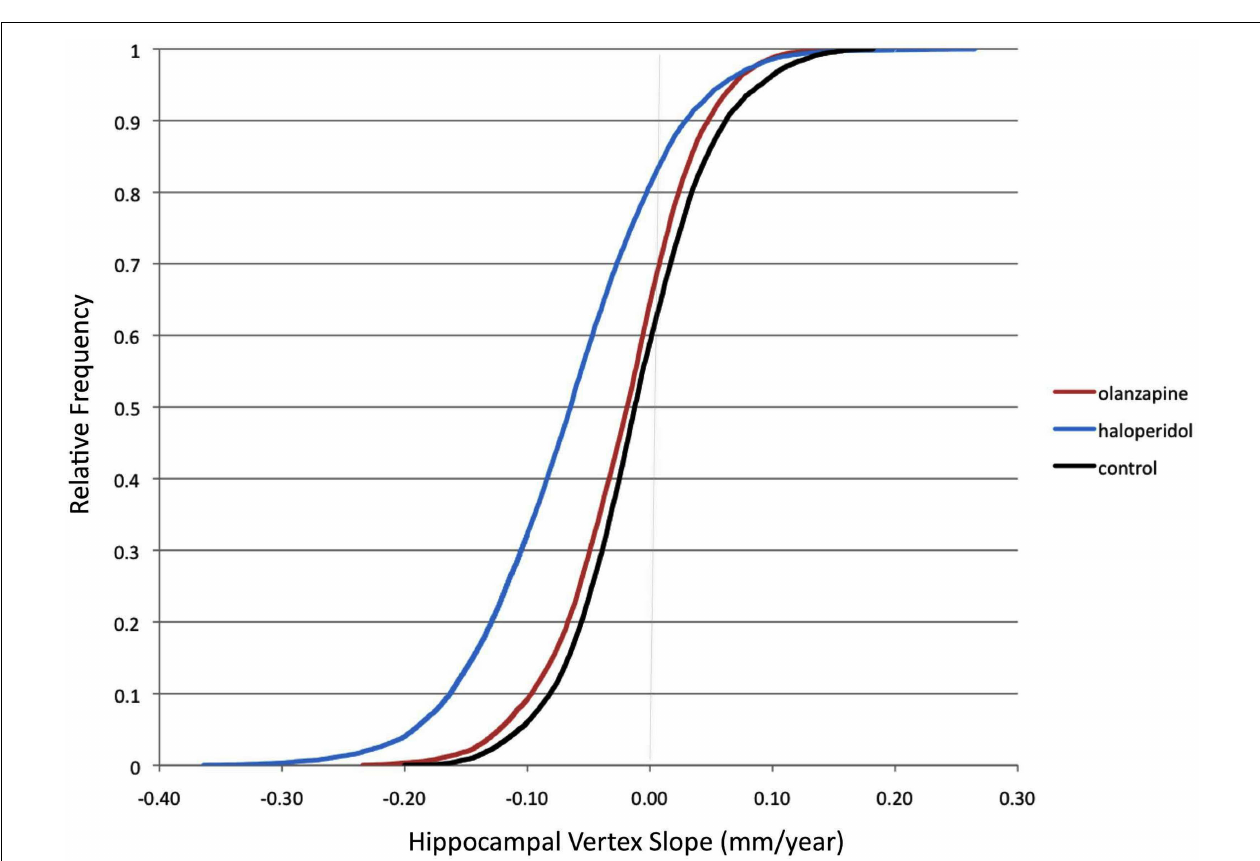
were calculated using all available visits (up to a maximum follow-up of 104weeks). Black = Healthy controls. Red = Olanzapine-treated patients. Blue = Haloperidol-treated